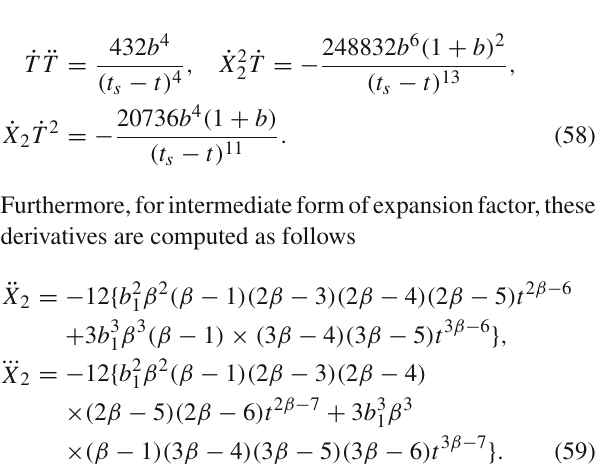
Fig. 14 Plot represents the validity regions for GSLT condition for equilibrium case in terms of cosmographic quantities for the model